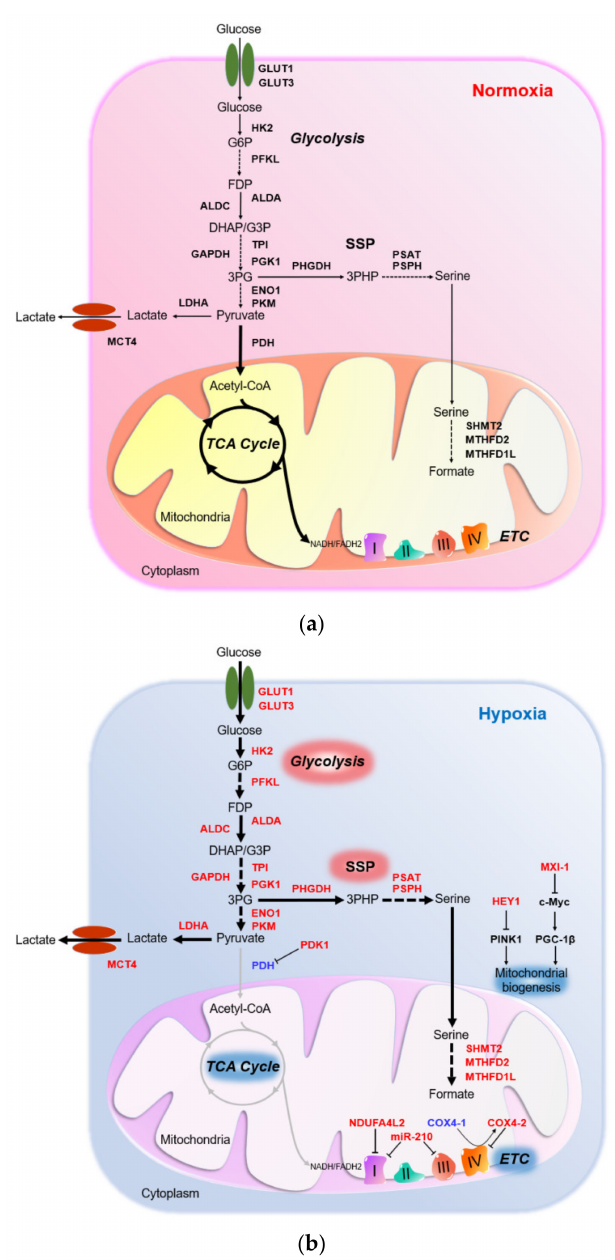
Figure 2. Hypoxia-inducible factors (HIFs) divert metabolites from tricarboxylic acid cycle (TCA) cycle to glycolysis under hypoxia. ( a ) Under normoxia, glucose is converted to pyruvate during glycolysis. Pyruvate is then converted to acetyl coenzyme A (acetyl-CoA), which fuels the TCA cycle for maximum adenosine triphosphate (ATP) production with ample oxygen (O 2 ) supply. ( b ) Un- der hypoxia, metabolism is switched from oxidative to glycolytic metabolism by HIF-dependent upregulation of pyruvate dehydrogenase kinase 1 (PDK1) and (lactate dehydrogenase A) LDHA. Lactate export is promoted to prevent excessive intracellular lactate accumulation, which may lead to cytoplasmic acidification. Serine synthesis pathway (SSP) and its downstream folate cycle are activated. Folate cycle produces a major antioxidant, nicotinamide adenine dinucleotide phosphate (NADPH), to counteract oxidative stress under hypoxia. Mitochondrial activity and biogenesis are suppressed to reduce mitochondrial reactive oxygen species (ROS) production. Genes or pathways highlighted in red: upregulated by HIFs. Genes or pathways highlighted in blue: downregulated by